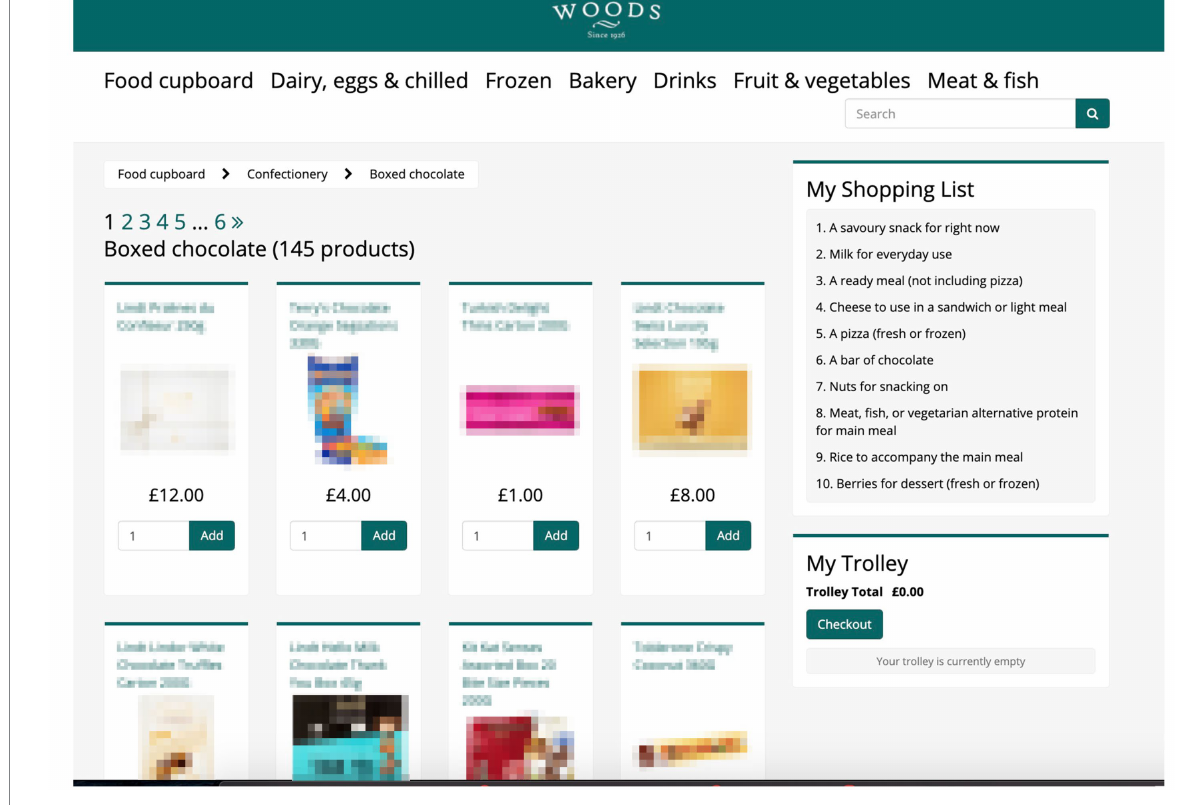
FIGURE 1 (A) Screenshot of the welcoming screen of the experimental online supermarket platform. (B) Screenshot of one of the product aisle pages of the experimental online supermarket